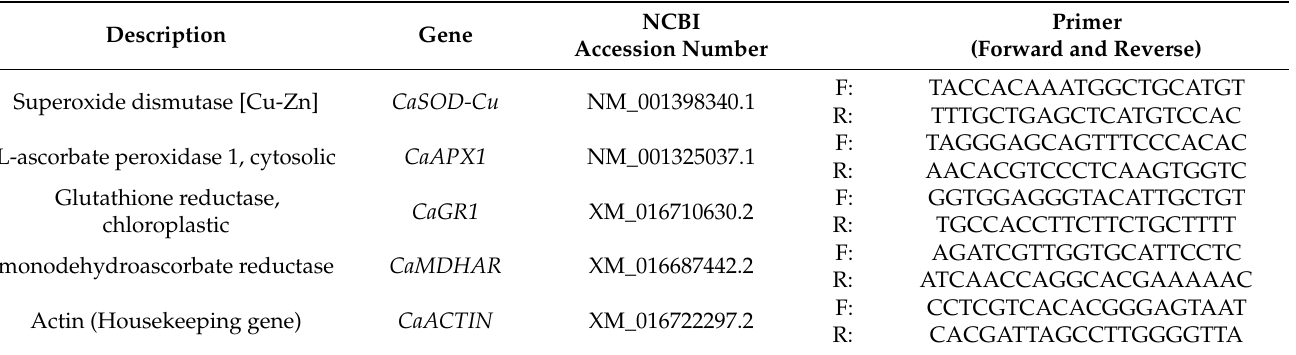
Table 2. Primers used for gene expression analysis of antioxidant-related genes of pepper ( Capsicum annuum ) using real-time